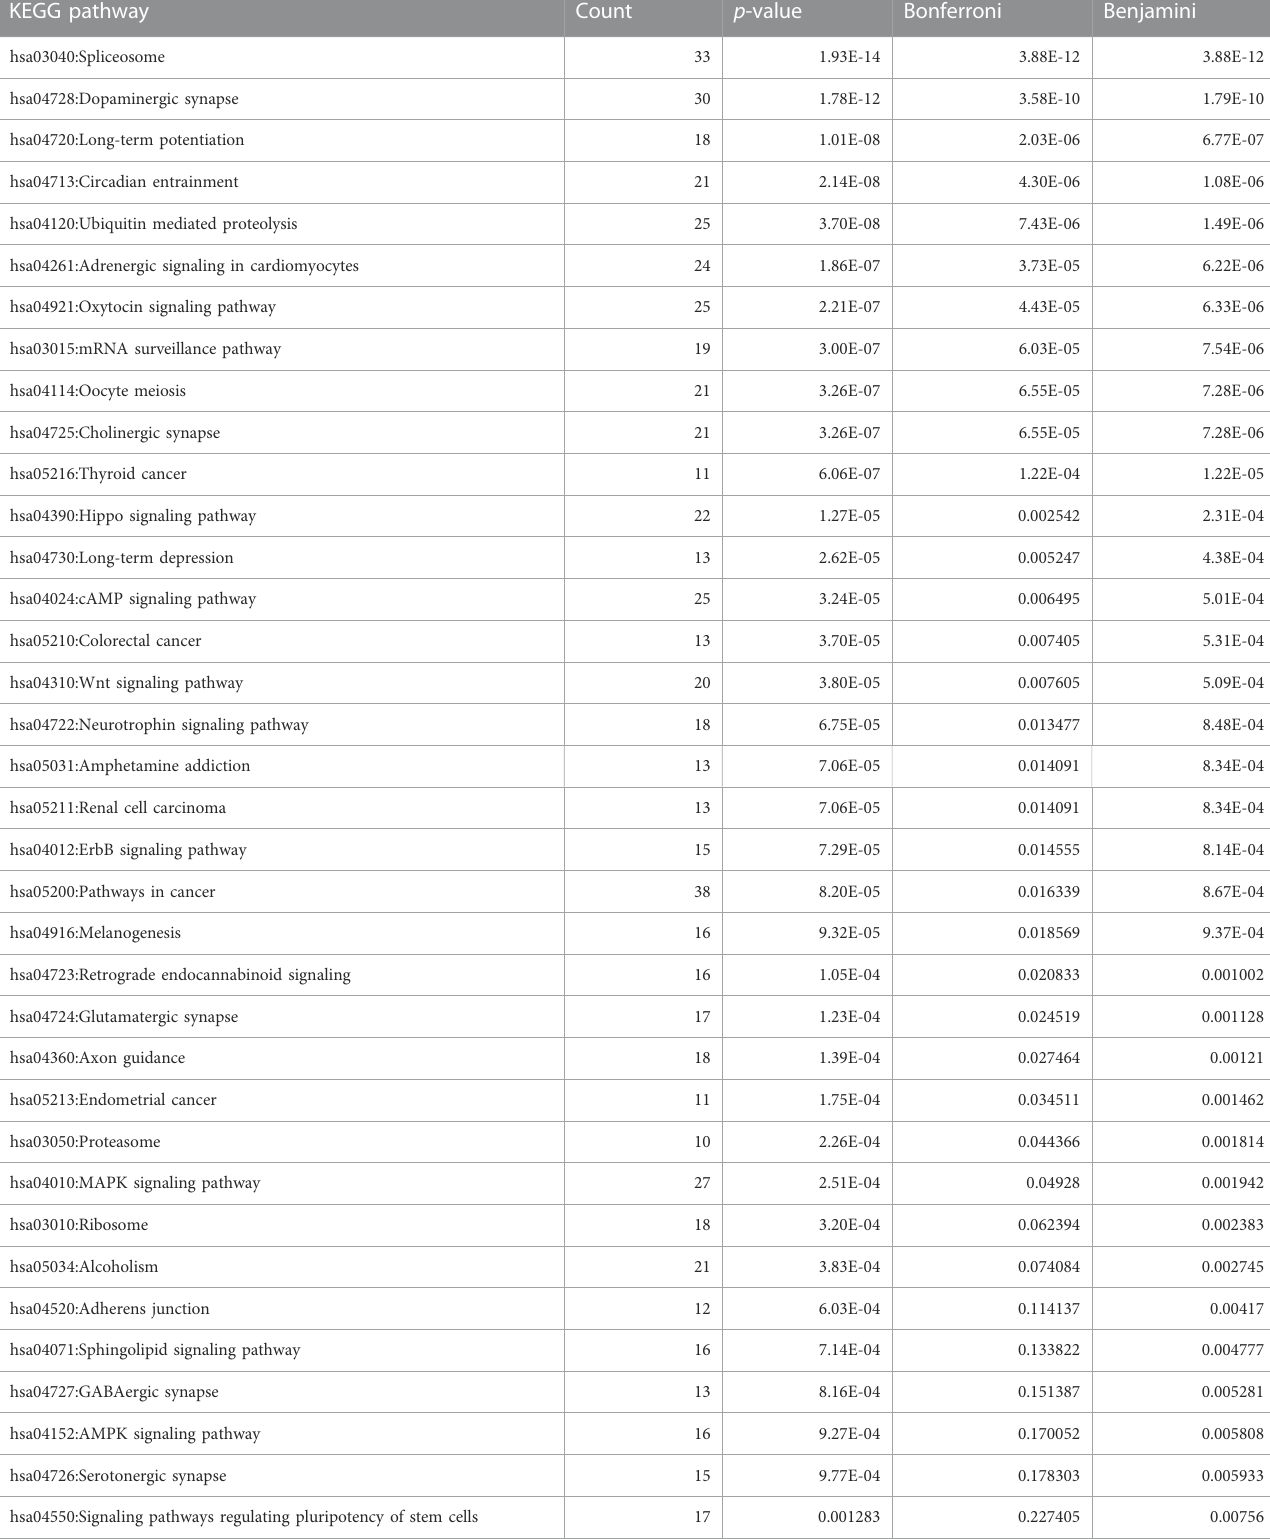
TABLE 8 KEGG Pathway Enrichment of 692 Most Conserved Orthologs. Pathway enrichment for the top 10% most conserved genes from among the core set of 6952 one-to-oneprotein-codingorthologsacrossall fi vespecies,shrew,ferret,dog,mouse,humananddog.Setofallpathwayenrichmentdataprovidesarepresentationof thebiochemicalandsignalingnetworksformedbythemostconservedorthologs.Amongtheenrichedpathwaysareneurotransmitterassociatedpathways(including dopamine synapse, serotonin synapse, oxytocin, adrenergic signaling, endocannabinoid signaling and GABA/Glutaminergic signaling), memory related pathways (such as long term potentiation, long term depression, and axon guidance) as well as neurobiology pathways associated with alcohol and amphetamine addiction. Count corresponds to the number of genes within the top 10% most conserved that were associated with the pathway, p -value corresponds to uncorrected p -value, Bonferroni refers to Bonferroni correction for multiple testing, and Benjamini corresponds to False Discovery